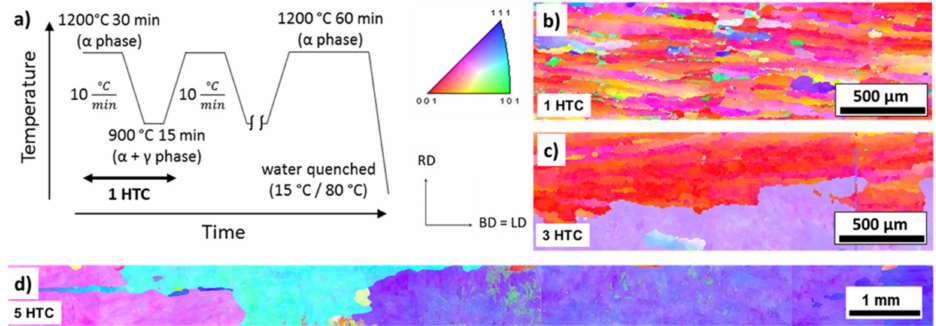
Figure 3. ( a ) Schematic highlighting a single heat treatment cycle (HTC) step (horizontal arrow) of the procedure employed to promote abnormal grain growth (AGG). ( b – d ) EBSD IPF maps depicting the cyclically heat-treated samples plotted in BD, after 1 HTC ( b ), 3 HTC ( c ), and 5 HTC ( d